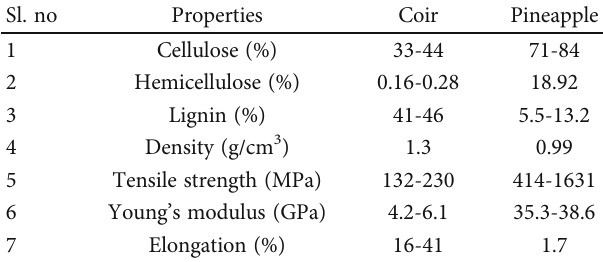
Elongation (%) Table 2: Parameters and their constraints of nanocomposites. Sample